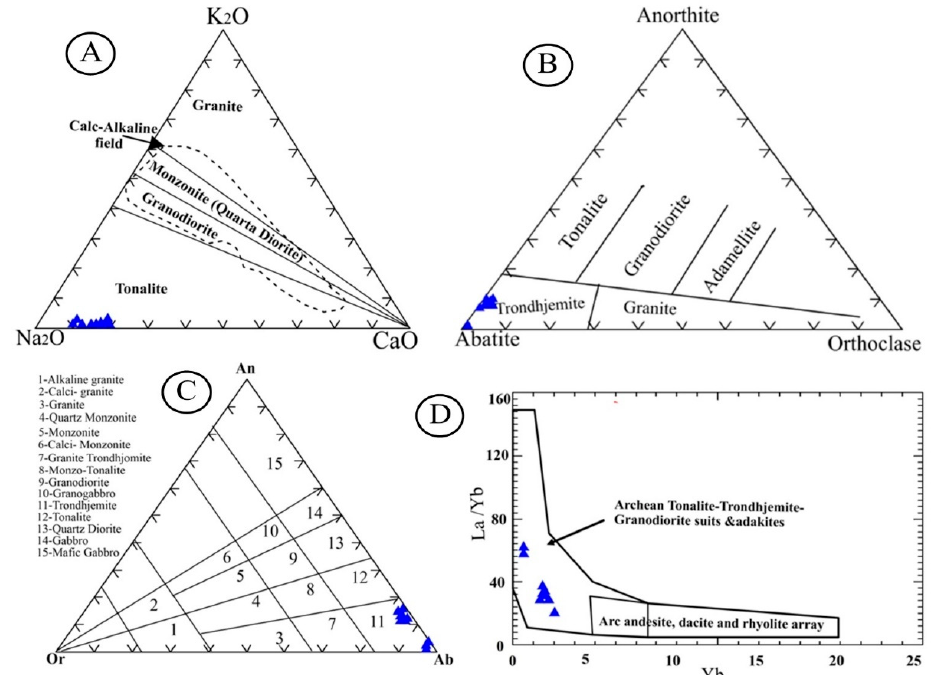
Figure 6. Geochemical classification of the Abu Dabbab plagio ‐ granites. ( A ) The CaO ‐ Na 2 O ‐ K 2 O ternary diagram of [55] for the Abu Dabbab plagio ‐ granites. ( B ) CIPW normative classification of the analyzed Abu ‐ Dabbab plagio ‐ granites, after [57] and modified by [59]. ( C ) Or ‐ An ‐ Ab ternary diagram of [56] for the Abu Dabbab plagio ‐ granites. ( D ) La/Yb ‐ Yb diagram shows the Abu Dabbab plagio ‐ granites, after [58].